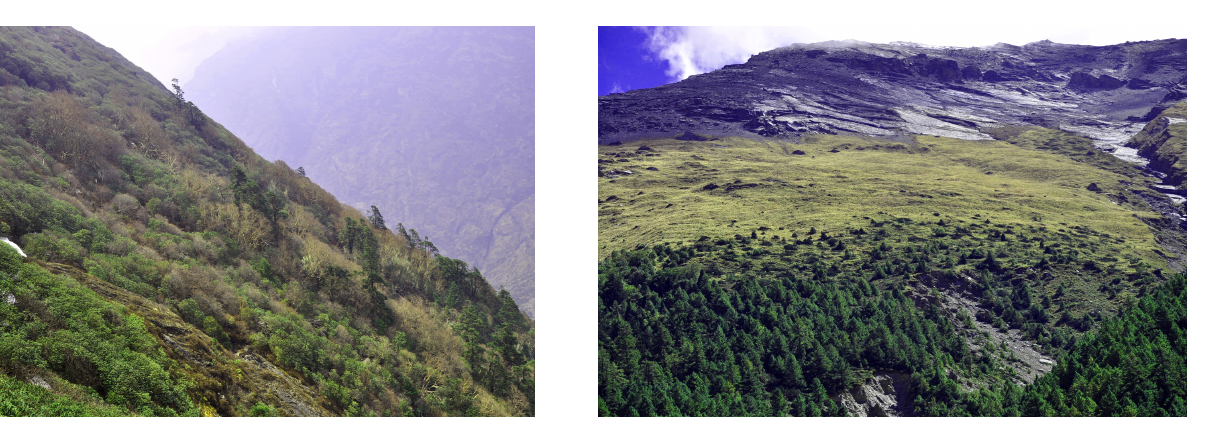
Figure 2. Altitudinal zonation of a near-natural north-facing tree- line in the central Himalaya: upper subalpine forests of Abies spectabilis and Betula utilis (leaves still unfolded) give way to Rhododendron campanulatum krummholz at ca. 4000m, Rolwal- ing, Nepal (Schickhoff, 15 April 2013.